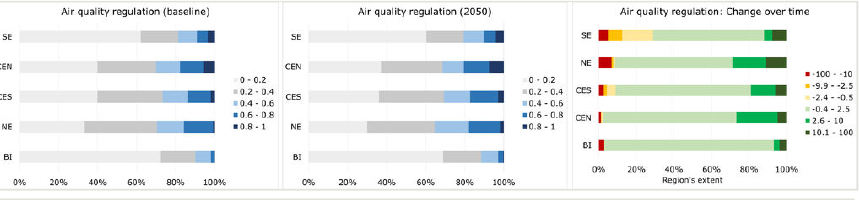
Fig. 7 quanti fi es the distribution of air quality regulation scores and relative change over time, across fi ve European regions (Suppl. material 3) identi fi ed on the basis of their climatic characteristics (Ciscar Martinez et al. 2011). In general, scores ≤ 0.2 characterised at least 40% of each region’s extent (a little less for North Europe, NE). This percentage was much greater in South Europe (SE) and on the British Isles (BI), where values of AQ ≤ 0.2 extended up to and above 60% of each region, respectively. The North part of Central Europe (CEN), recorded the greatest percentage in high supply of air quality regulation (scores ≥ 0.8). These patterns were generally conserved over time (2050 vs. baseline), with the vast majority of the areas registering changes between -0.4 and + 2.5 % across the fi ve regions (Fig. 7, panel ‘Change over time’). South Europe, however, also registered noticeable negative changes, over about 30% of the area, whilst Central and North Europe showed changes in scores ≥ 2.5% over ca. 20% of their area. In addition, North Europe was the region with the greatest extent of the most negative changes.